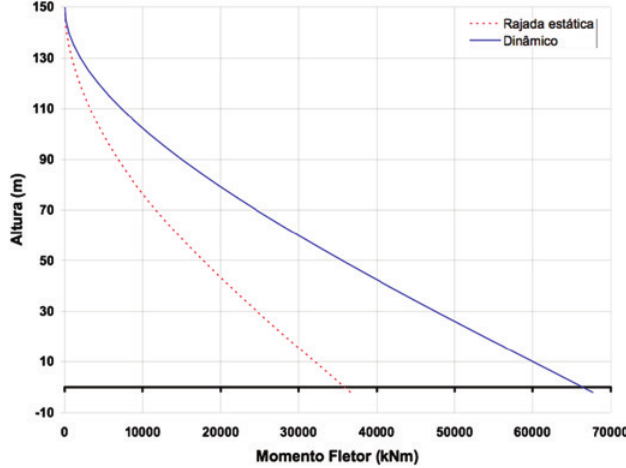
Figure 19 Comparison between the static gust method and the dynamic approach for the surrounding of the chimney with aerodynamic coefficients obtained from the wind constants C1 e C2 have values of 6 and 1.2, respectively. The critical damping ratio used β = 0.01 and the slenderness λ = 29.4. The